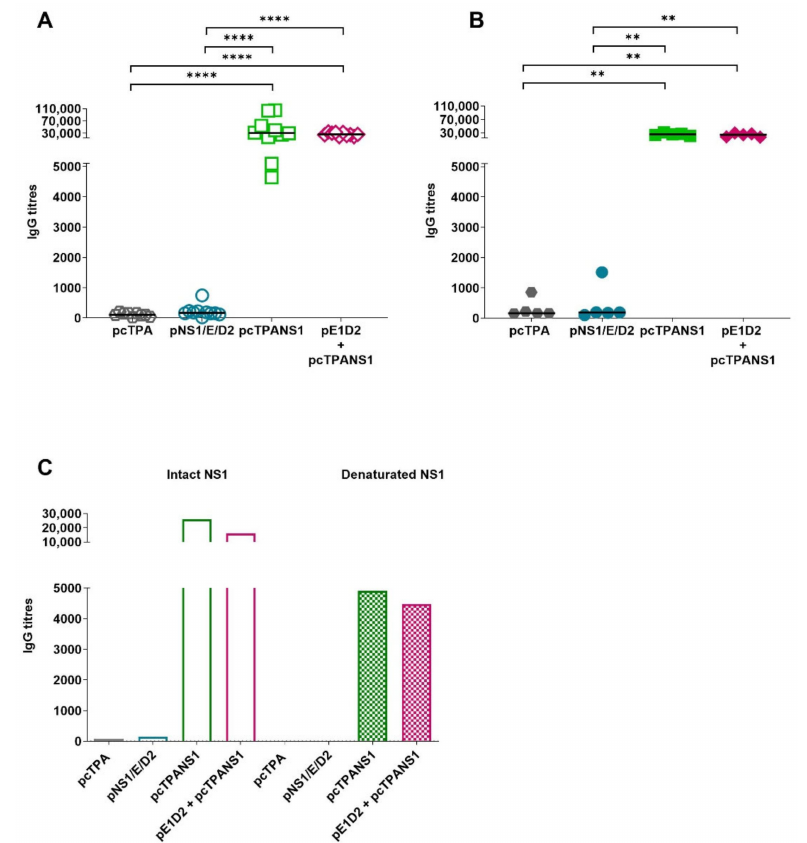
Figure 5. Antibody response against the NS1 protein in serum samples of BALB/c mice immunized with the different DNA vaccines. Antibody titration against the NS1 protein was performed by ELISA using serum samples from mice inoculated with the plasmids pNS1/E/D2, pcTPANS1, pE1D2, or pcTPA alone, as well as with the mixture of pE1D2 + pcTPANS1. Serum samples date from 2 ( A ) or 4 weeks ( B ) after the second DNA dose. Samples from each animal were individually tested in duplicates, and bars represent the median of the obtained values. All ELISA assays were performed using the intact NS1 protein, except in ( C ), in which both intact and heat-denatured proteins were used for testing pooled serum samples of five mice per group (data shown are the median of the obtained values). Asterisks in A and B indicate statistically significant differences between experimental groups using the non-parametric two-tailed Mann–Whitney test (** p < 0.01; **** p < 0.0001). Data obtained with sera collected 2 weeks after the last immunization are representative of two independent experiments ( n =